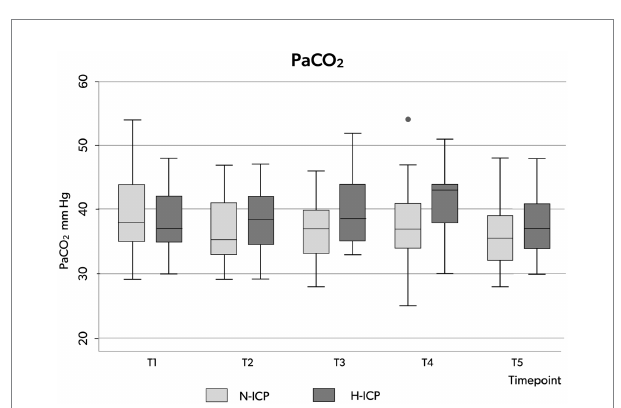
FIGURE 5 Box plots illustrating the distribution of PaCO2 values (minimum value, first quartile, median, third quartile, and maximum value) at the five time points in patients presenting with N-ICP (light gray boxes) and H-ICP (dark gray boxes). PaCO 2 , partial pressure of carbon dioxide in the arterial blood; N-ICP, normal intracranial pressure; H-ICP, high intracranial